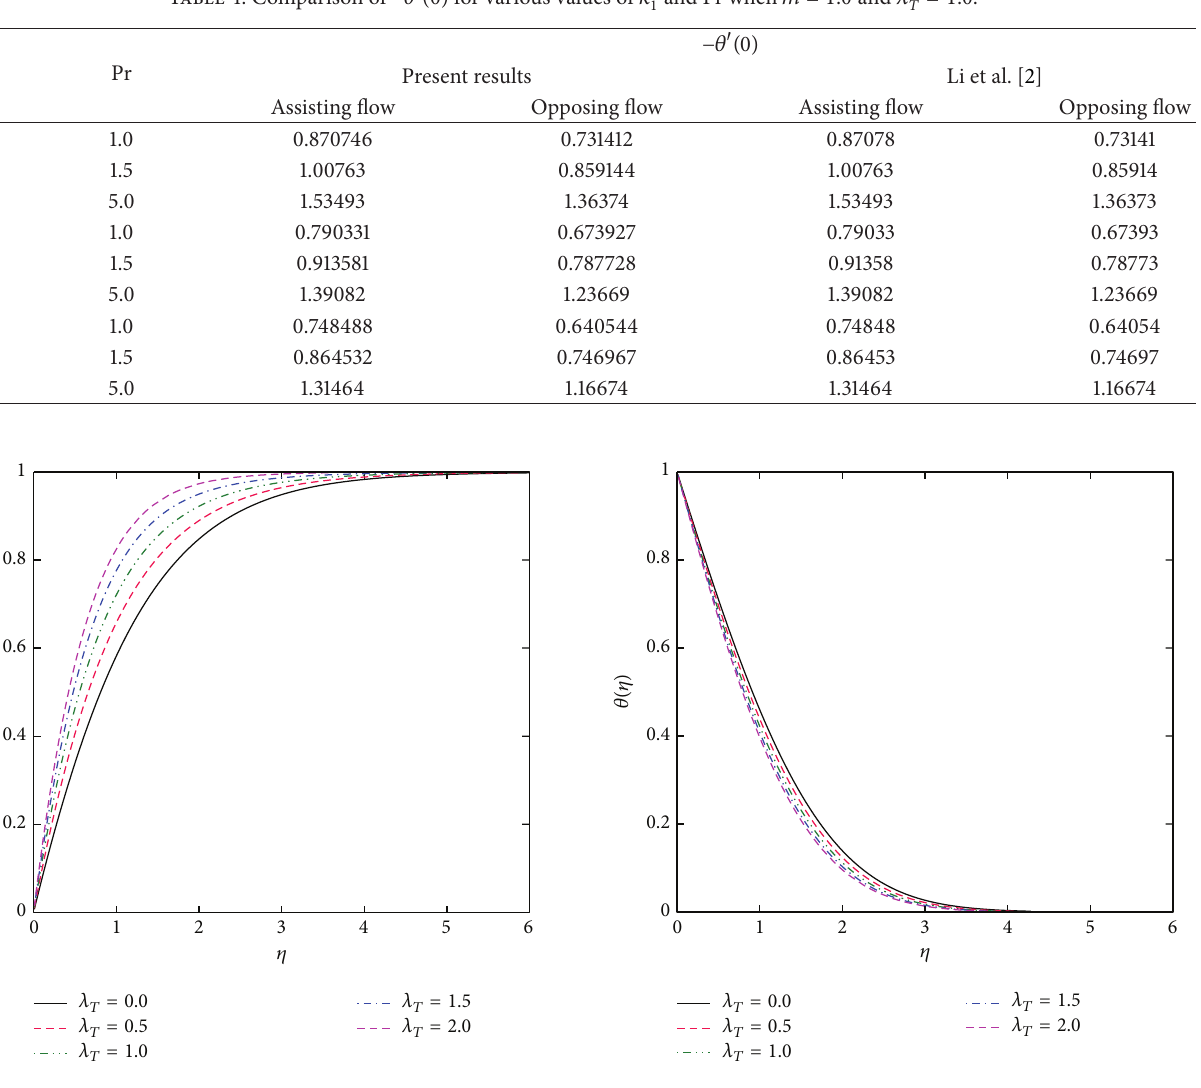
Figure 9: The effect of 𝜆 𝑇 on temperature profile when 𝑘 1 = 0.6 , Pr = 1.0 , and 𝑚 = 0.5